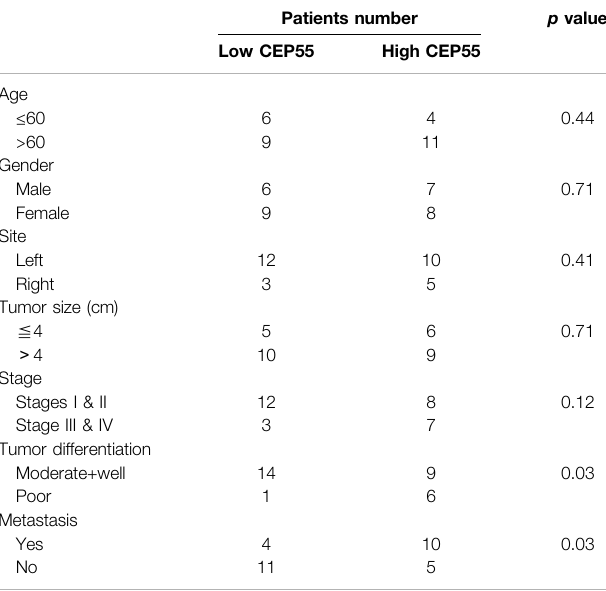
TABLE 6 | The clinical features of low and high CEP55 expression in Fn-infected CRC patients.